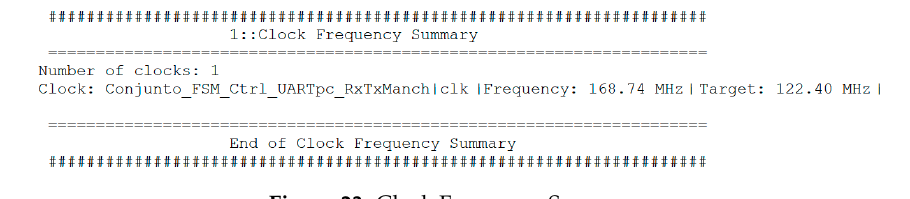
Figure 23. Clock Frequency Summary.